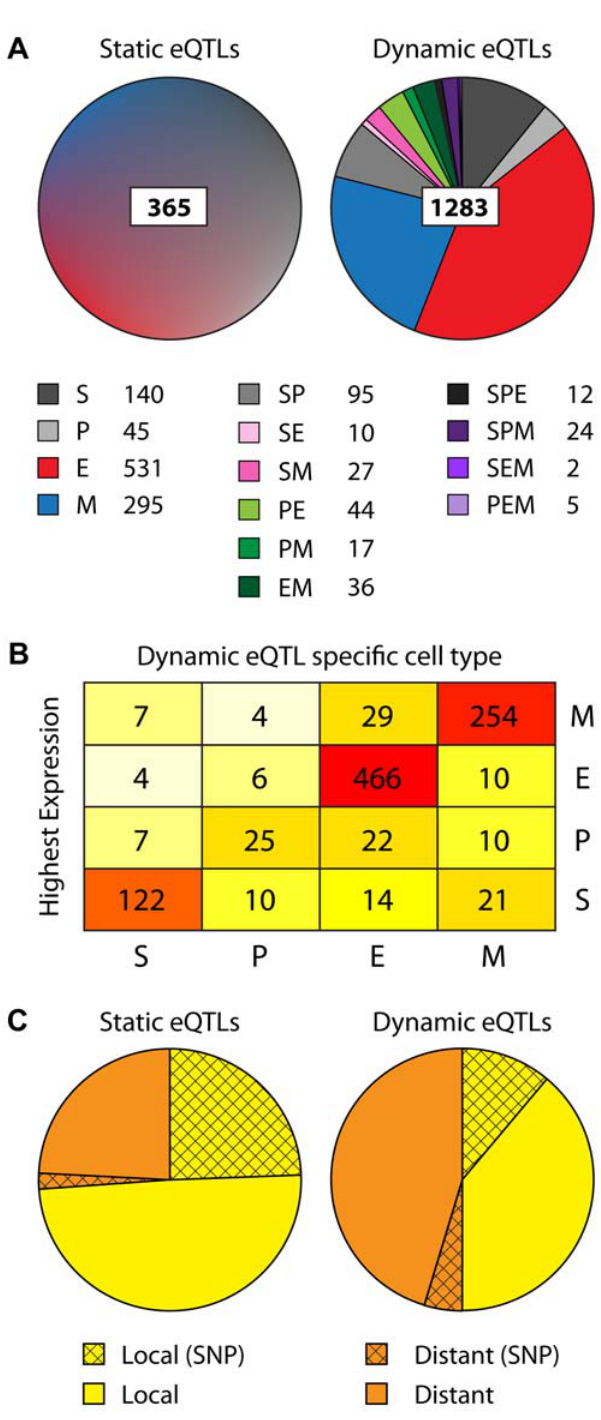
Figure 3. Quantitative overview of static and dynamic eQTLs. (A) Pie charts presenting all 365 static and 1283 dynamic eQTLs that were detected with p , 10 2 6 . Dynamic eQTLs are subdivided in all 14 categories of interaction eQTLs. (B) Matrix showing the four cell-type– dependent dynamic eQTL categories and the cell type in which the gene was expressed most highly. (C) All static and dynamic eQTLs are subdivided in local and distant eQTLs. Shown is which number of eQTLs was detected by Illumina probes that hybridize to sequences that are known to contain polymorphisms (SNPs) between the two parental strains. Abbreviations: S, stem cells; P, progenitor cells; E, erythroid cells; M, myeloid cells.